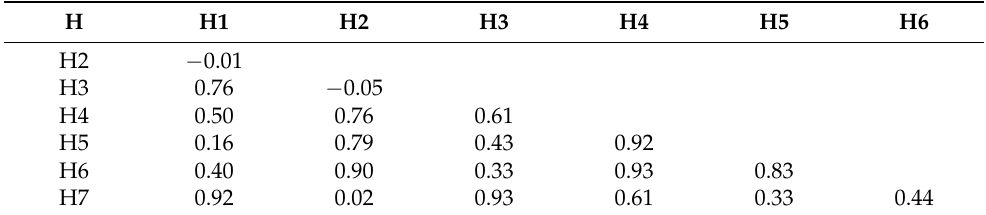
Table 7. Correlations among aggregate genotypes